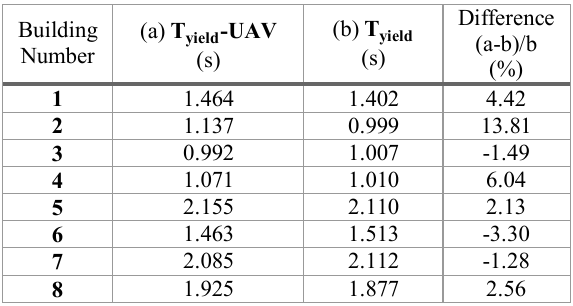
Table 2. Estimated periods and their